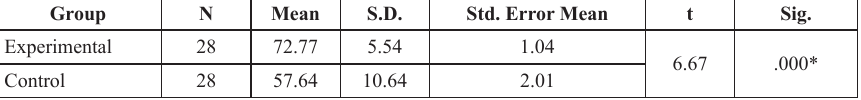
Table 5. The mean scores of mathematical conceptual understanding for post-tests according to learning approach Group N Mean S.D. Std. Error Mean t Sig. Experimental 28 72.77 5.54 1.04 6.67 .000* Control 28 57.64 10.64